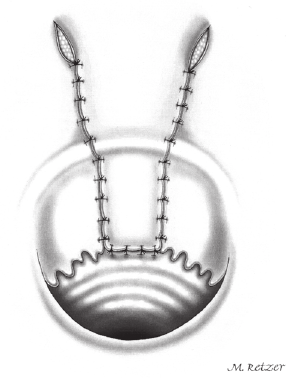
Figure 2 - Musiari´s anoplasty. After an incision made in the fibrotic area, a rectangular flap is created and suturing to the line of resection is performed without